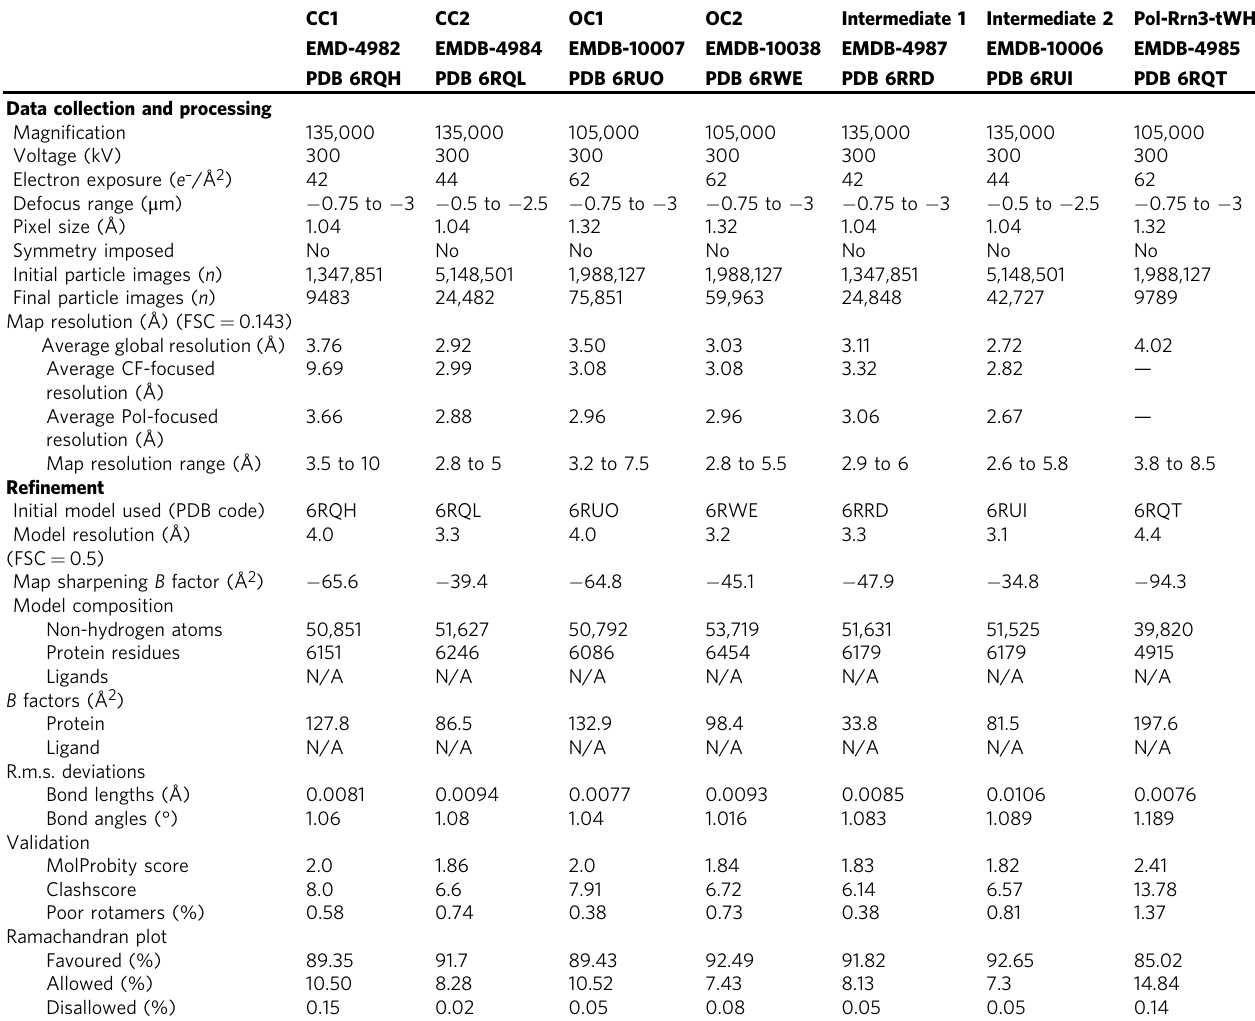
Table 1 Cryo-EM data collection, re fi nement and validation